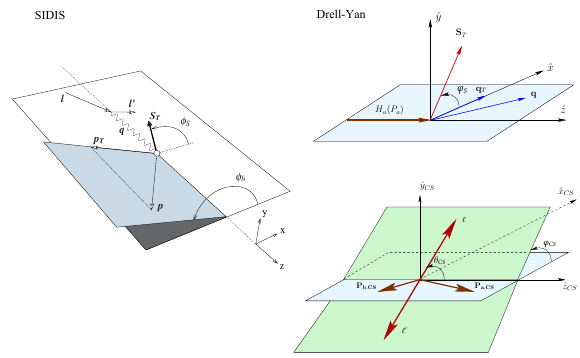
Figure 1. SIDIS and Drell-Yan frameworks and notations. Table 1. Nucleon TMD PDFs accessed via SIDIS and